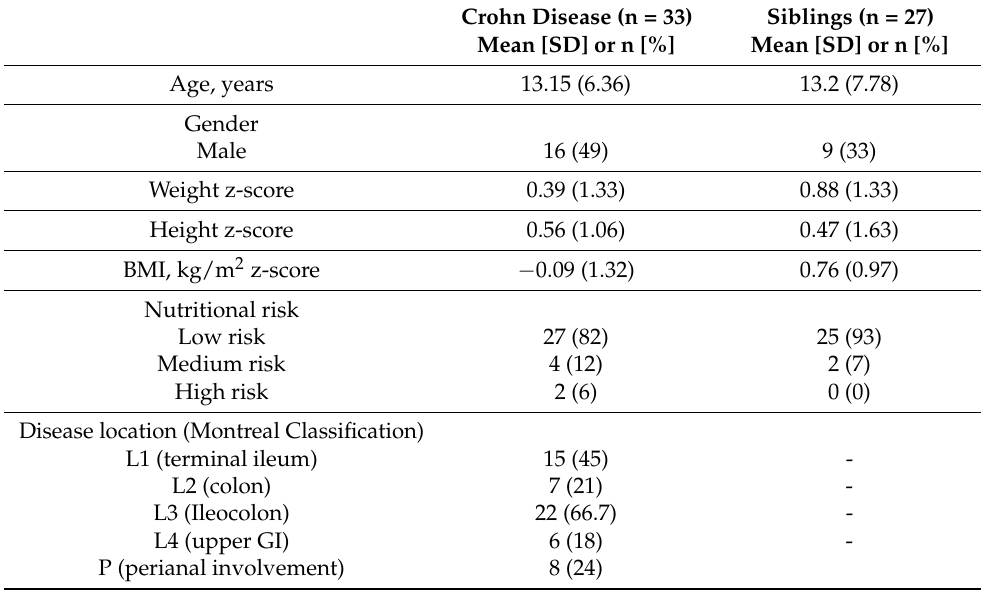
Table 1. Participant characteristics and